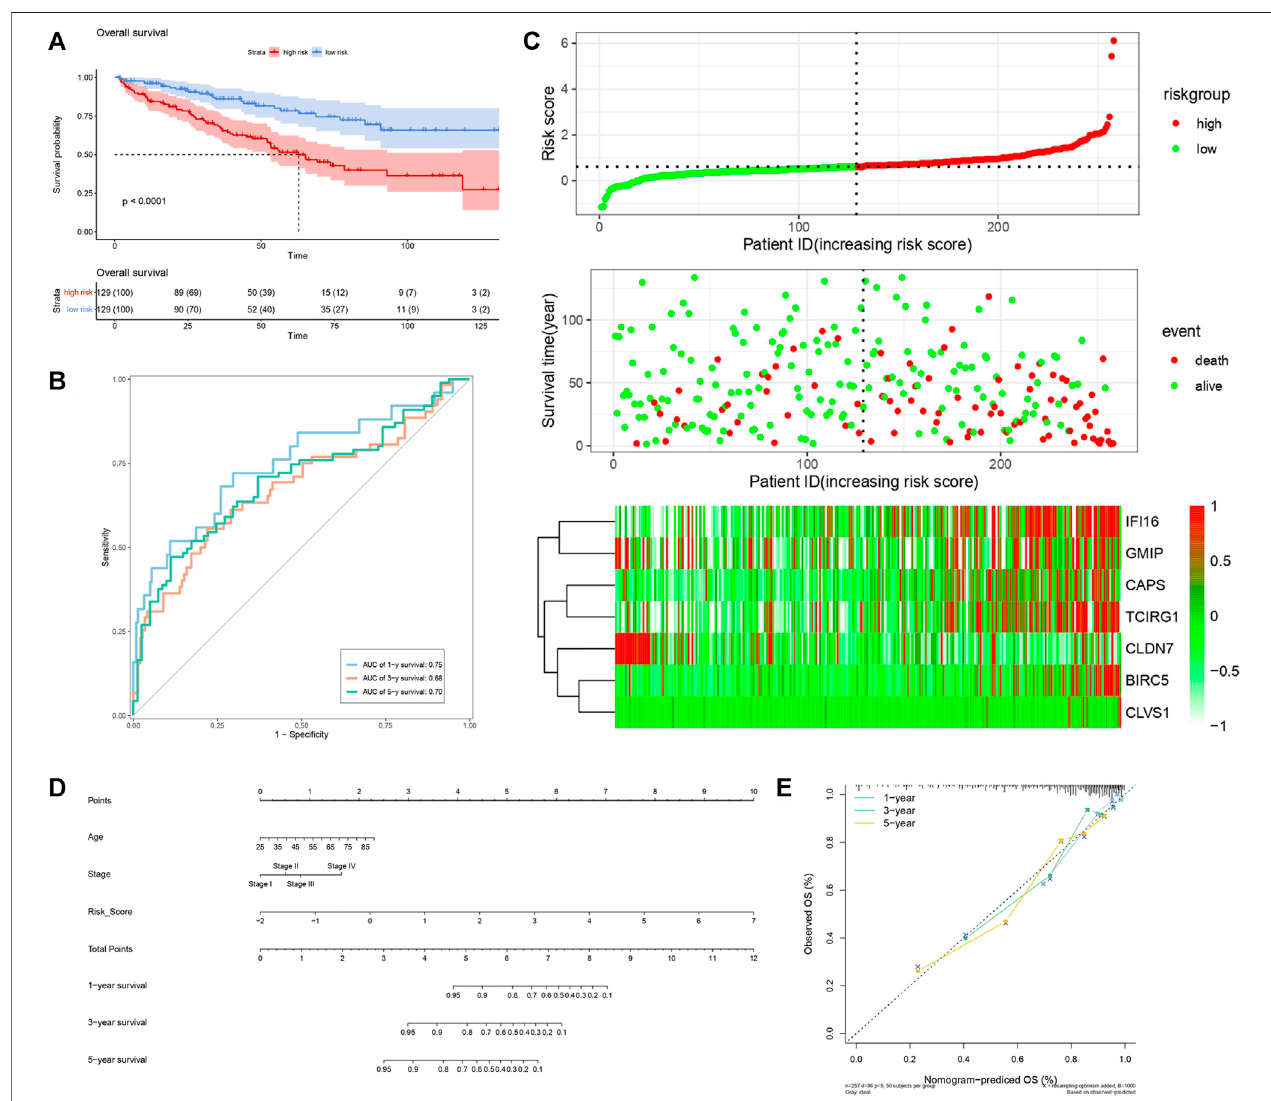
FIGURE 7 | Veri fi cation of risk score as predicting factor of ccRCC patients in train cohort. (A) Survival curve of different groups. Red line represented patients in high riskgroup,blue linerepresentedpatientsinlowriskgroup. (B) Time-dependentROCcurveof1-,3-,5-years. (C) Risk factorassociationdiagram. Rednodes inthe upper and middle graph represented patients with high risk score, green nodes represented patients with low risk score. Cells in the gram below represented each patients and color of cells indicated up- or down-regulation of genes. (D) Nomogram included age, stage, and 7 gene-based risk score. (E) Calibration curve was depicted for veri fi cation accurancy of nomogram predicting 1-, 3-, 5-years OS